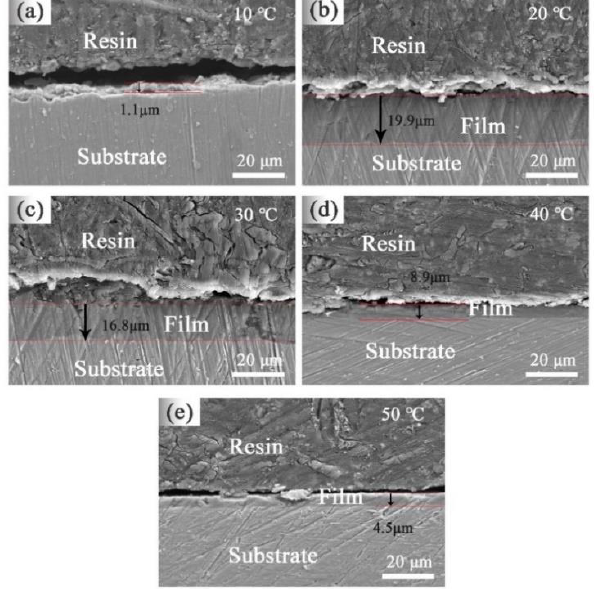
Figure 5. Cross-sectional FE-SEM micrographs of the composite anodic films fabricated at different temperatures. ( a ) 10 °C, ( b ) 20 °C, ( c ) 30 °C, ( d ) 40 °C, ( e ) 50 °C.